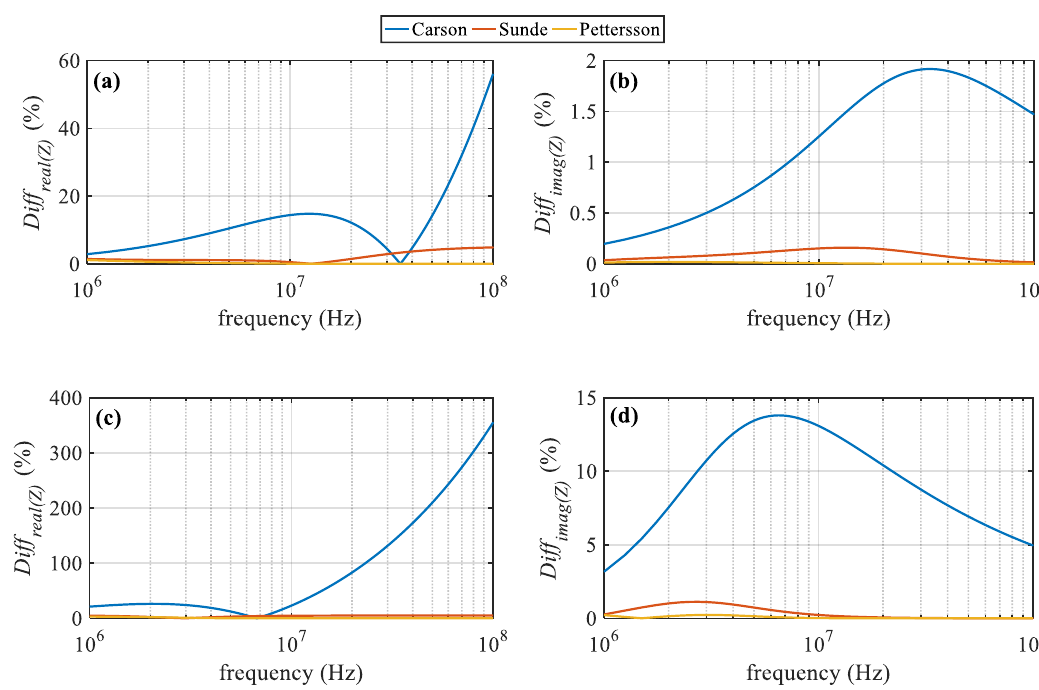
Figure 18. Di ff erences in Z 13 in BB. For ρ g = 100 Ω m, ε rg = 10, ( a ) real part, ( b ) imaginary part, Figure 18. Differences in Z 13 in BB. F or ρ g = 100 Ωm, ε rg = 10, ( a ) real part, ( b ) imaginary part, for ρ g = for ρ g = 1000 Ω m, ε rg = 10, ( c ) real part and ( d ) imaginary 1000 Ωm, ε rg = 10, ( c ) real part and ( d ) imaginary part.